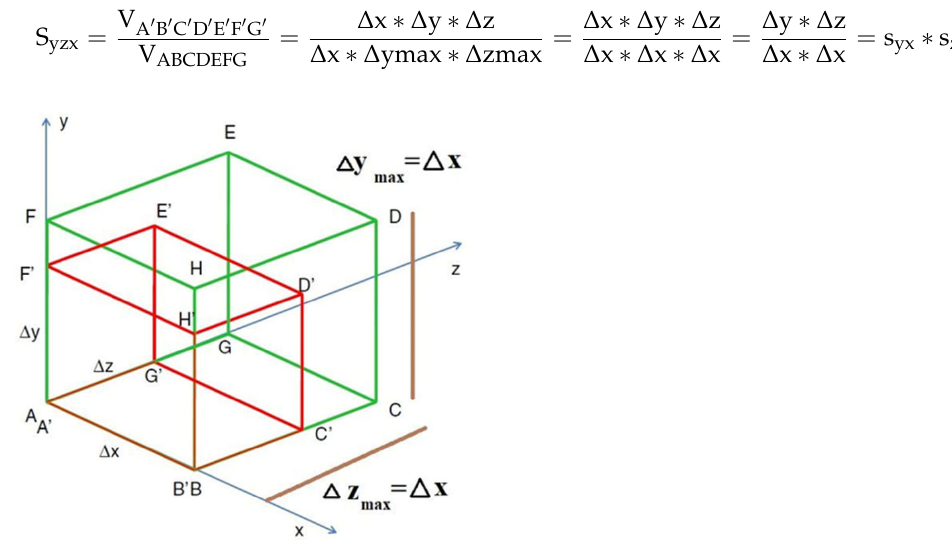
Figure 3. Synergy measurement of three variables. Source: Adapted from